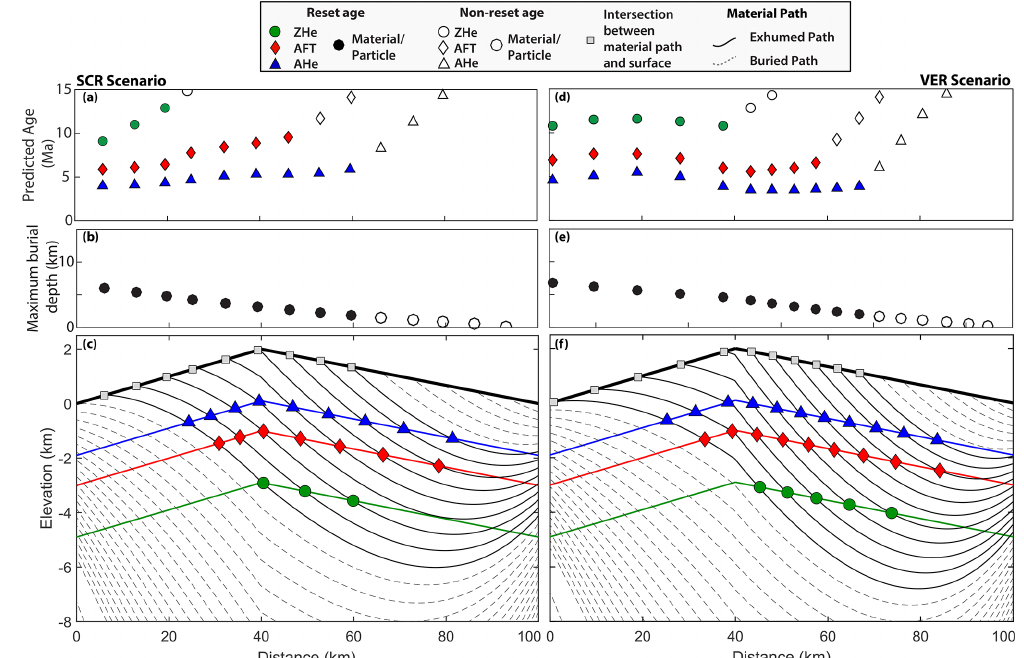
Figure 11. Closeup (vertical axis only) of kinematic model shown in Fig. 10. Left and right panels represent the spatially constant erosion rate (SCR) and variable erosion rate (VER) model setups, respectively. (a, d) Predicted age of thermochronometers with distance along the wedge. (b, e) Predicted maximum burial depths for each particle path. (c, f) Material paths in upper 8km of kinematic model. Coloured lines illustrate closure depths for AHe, AFT, and ZHe